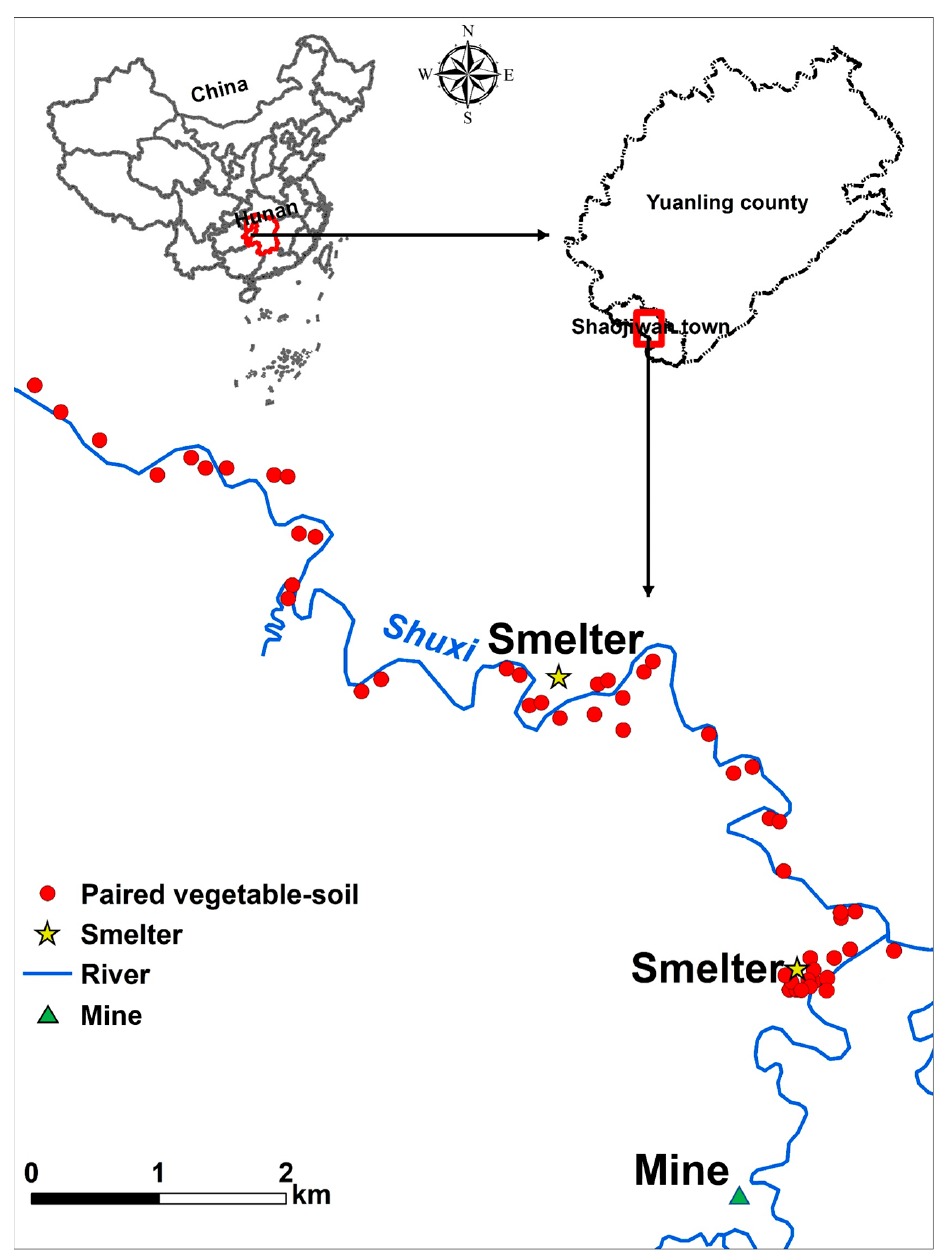
Figure 1. Study area and sampling sites.